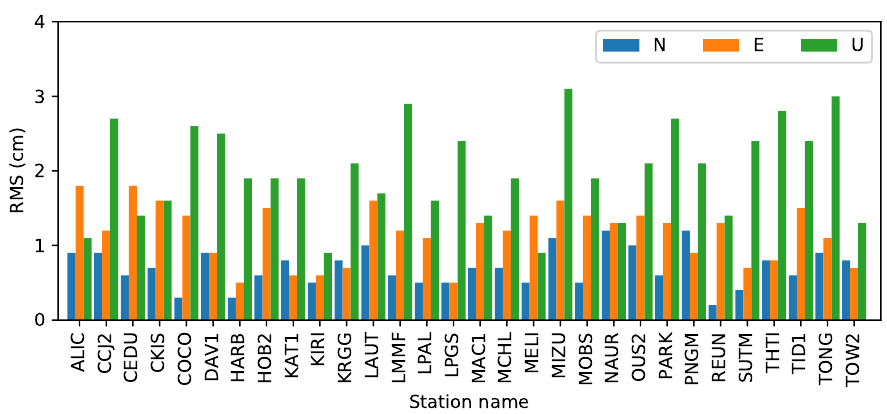
Figure 5. Positioning errors of real-time static PPP experiments. The mean RMS values are 0.7, 1.2, and 2.1 cm in the north, east, and west components,